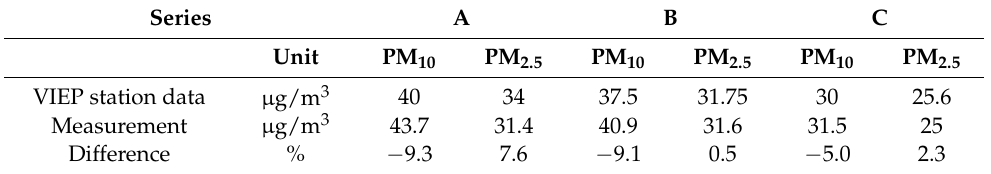
Table 2. The difference between the measurement data and the data from the VIEP station.